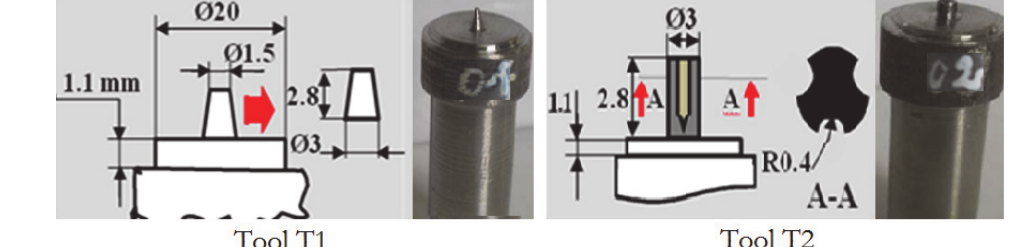
Figure 5: Geometry of the tools.